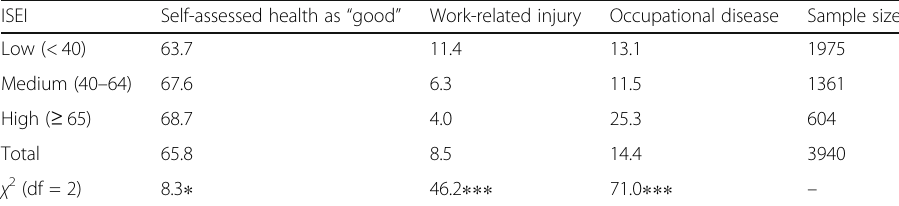
Table 2 Health status among different occupational status groups (%) ISEI Self-assessed health as “ good ” Work-related injury Occupational disease Sample size Low (< 40) 63.7 High ( ≥ 65) 68.7